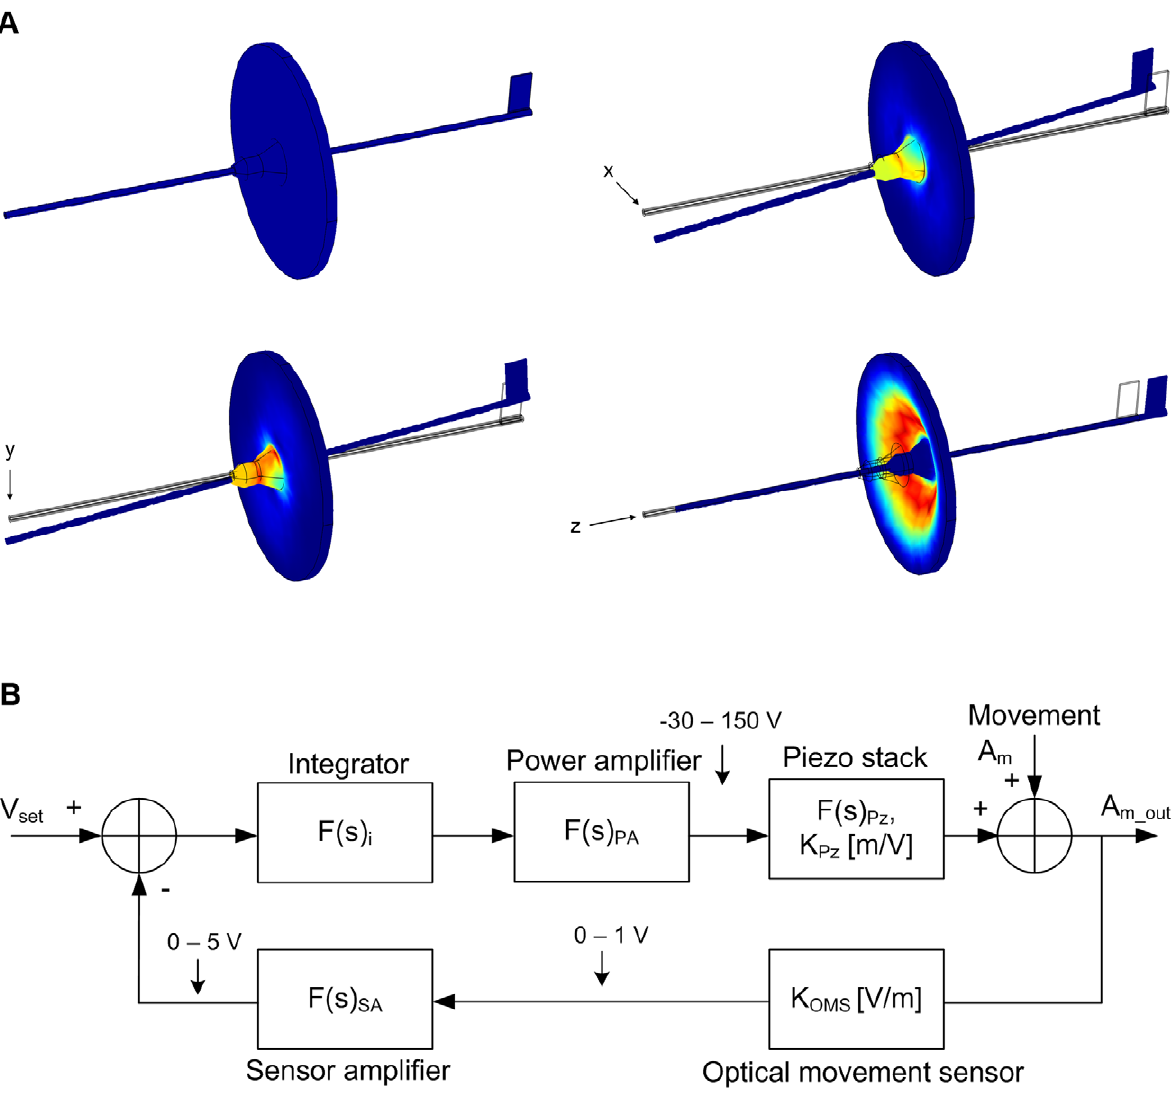
Figure 3. Modeling and simulations. A, Simulations of the 3D sensor movement in response to manipulation of the probe tip; colors illustrate strain of the film. B, Schematic representation of the linear model of one axis of the stabilization system control loop.